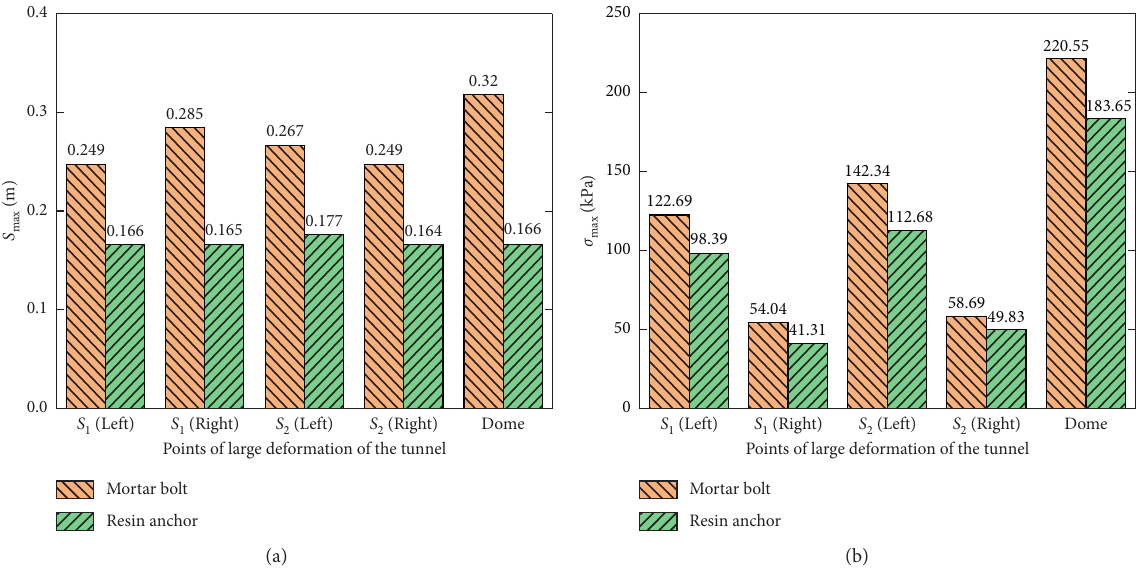
Figure 8: The distance between mortar bolt and resin bolt support is reduced to 0.7m: (a) S point.